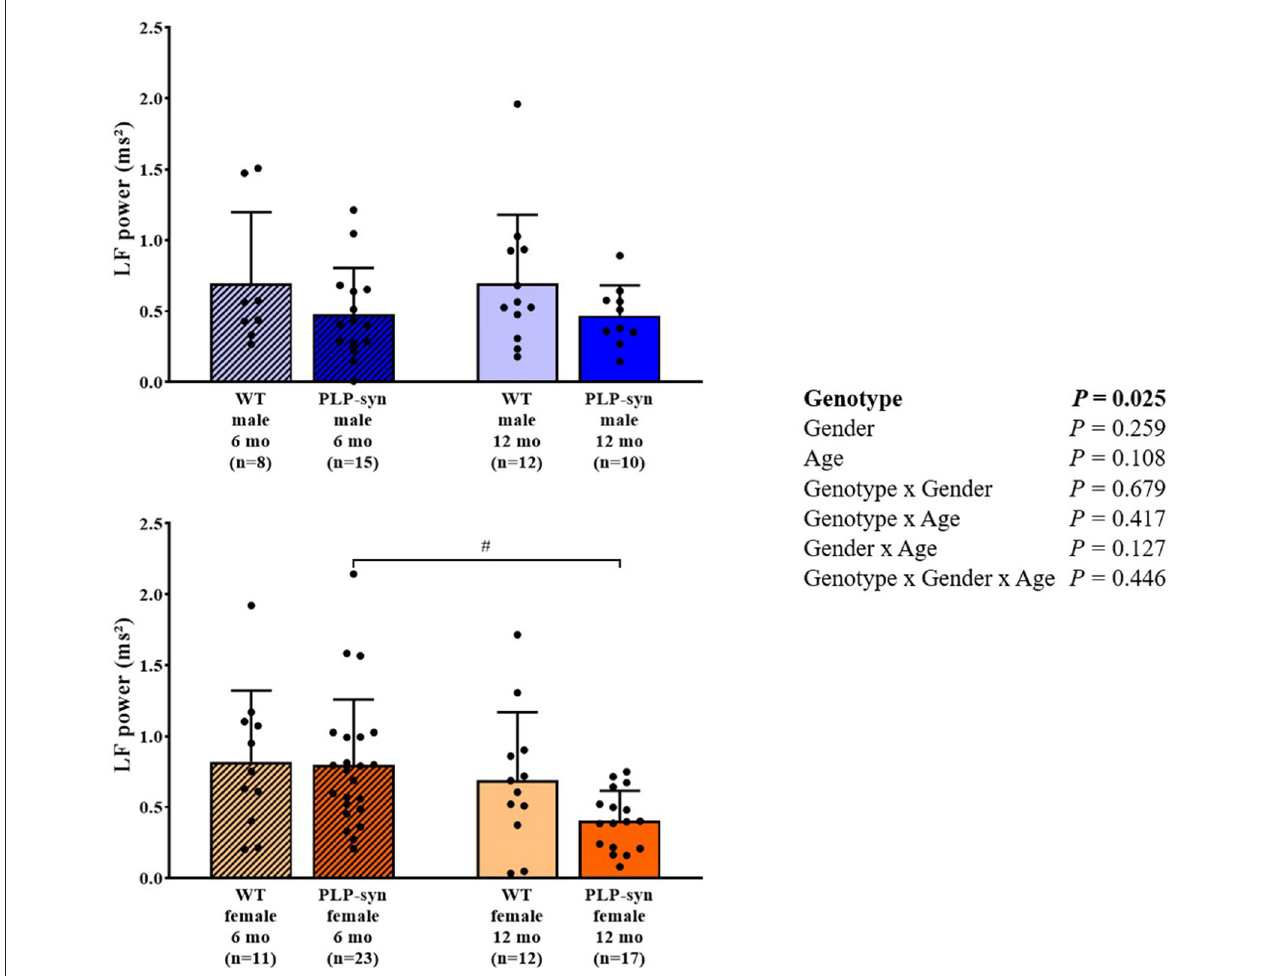
FIGURE 3 | LF power in 6 and 12 months, male and female, WT and PLP- α -syn mice. LF, low frequency. # P < 0.05 vs. PLP- α -syn female 6 mo. Black circles represent individual points.